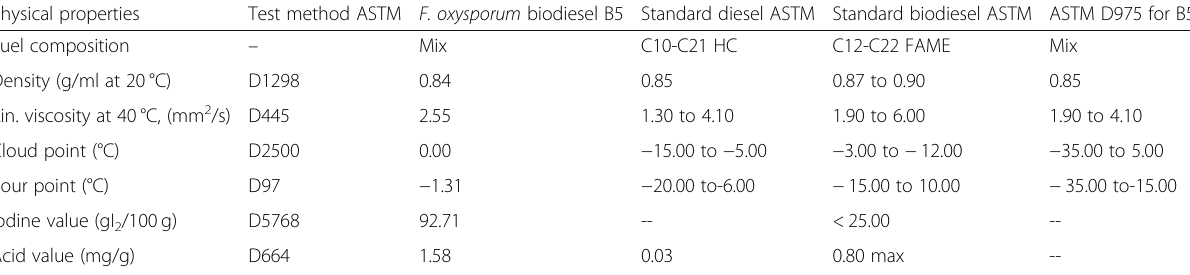
Table 1 Physical properties obtained from blending biodiesel F. oxysporum NRC2017 as compared with standard diesel ASTM, standard biodiesel ASTM, and ASTM D975 (standard biodiesel for B5) Physical